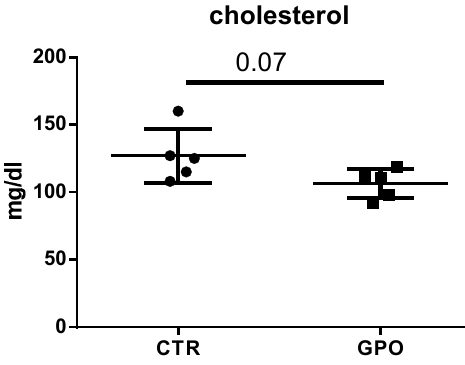
Figure 5. Effect of GPO-supplemented diet on plasma cholesterol levels. Each point represents a single subject and differences were analyzed using the Student’s t -test.